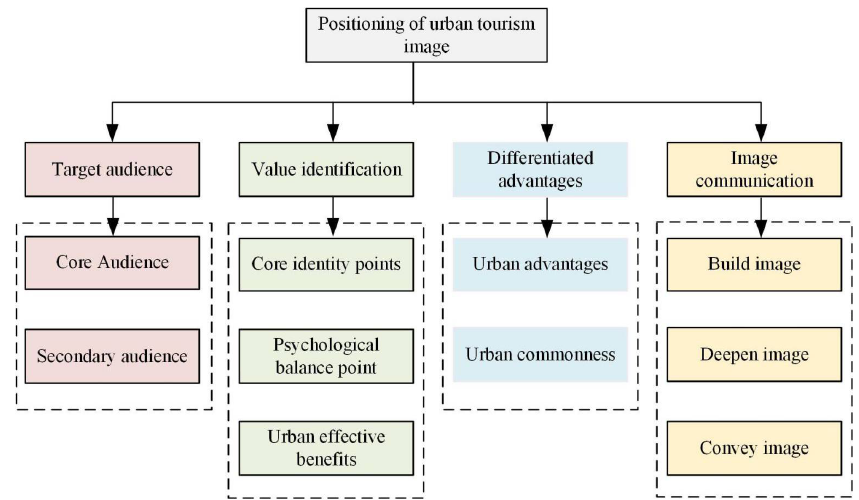
Figure 3. The positioning connotation of urban tourism image (drawn from research analysis after reviewing the data). reviewing the